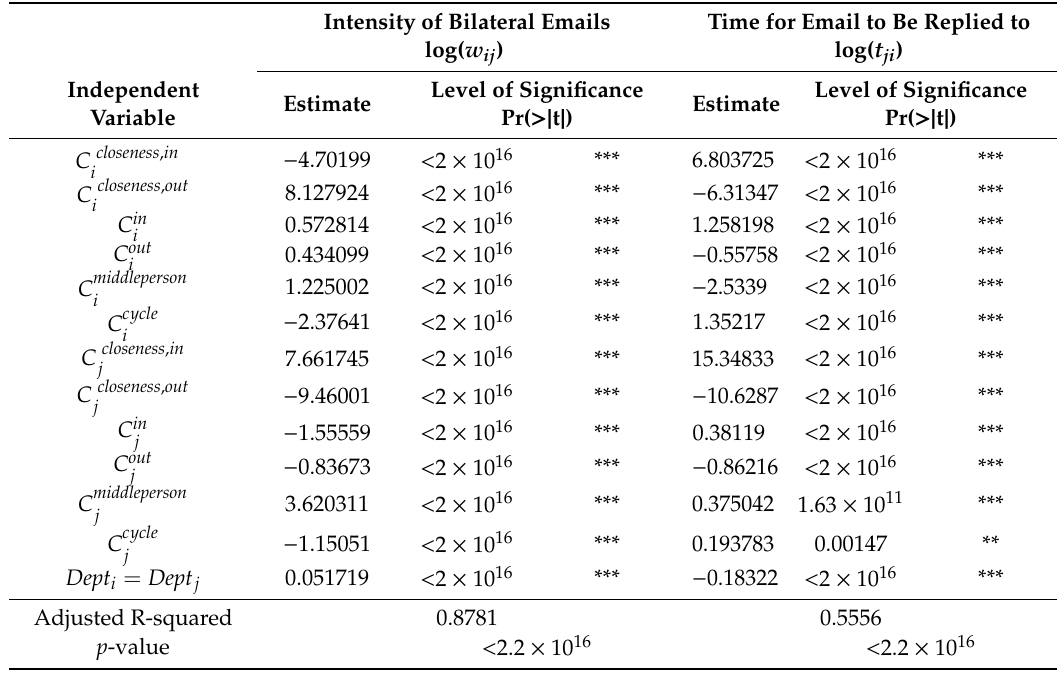
Table 4. Summary of model estimates and levels of